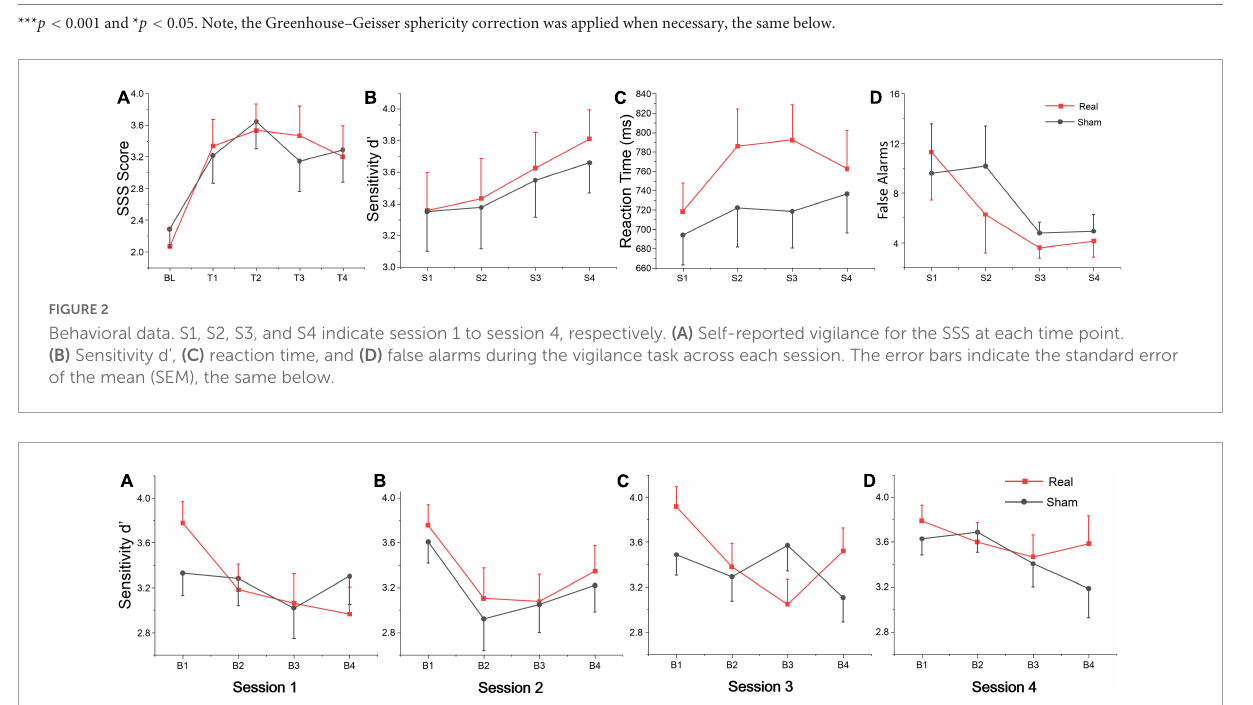
FIGURE3 Sensitivity d’ per block across four sessions: (A) Session 1, (B) Session 2, (C) Session 3, and (D) Session 4. Each session was divided into four blocks (B1, B2, B3, and